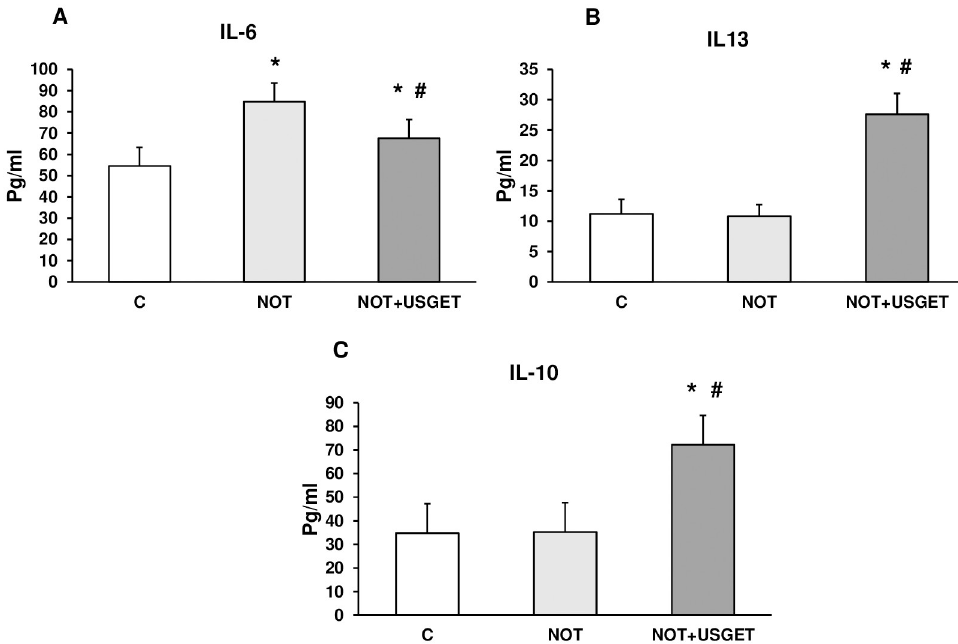
Fig 2. Plasma from rats without notexin (C) or notexin (NOT) or notexin with USGTE (6 mA) (NOT+USGTE) was collected. IL-6 (A), IL-13 (B), and IL-10 (C) were determined by ELISA. Values are means ± SD from five independent experiments. � p < 0.03 vs. control. #p < 0.03 vs. notexin.